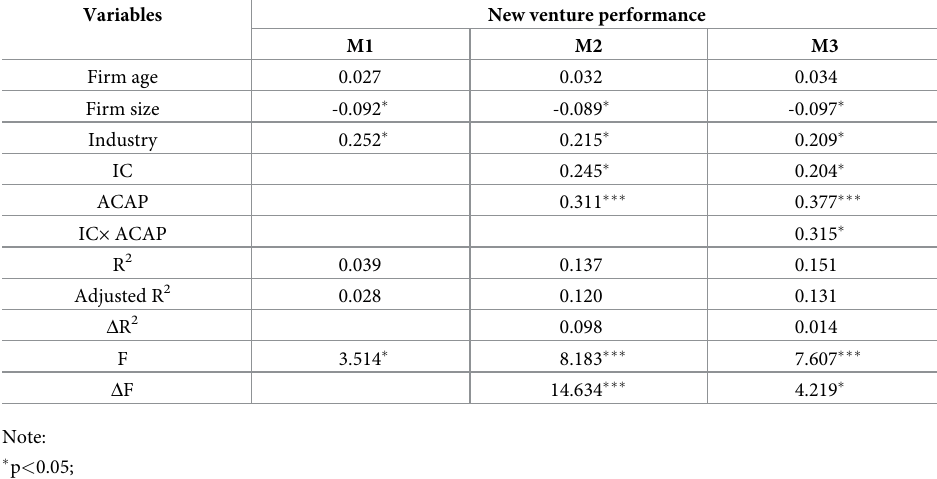
Table 5. Hierarchical multiple regression